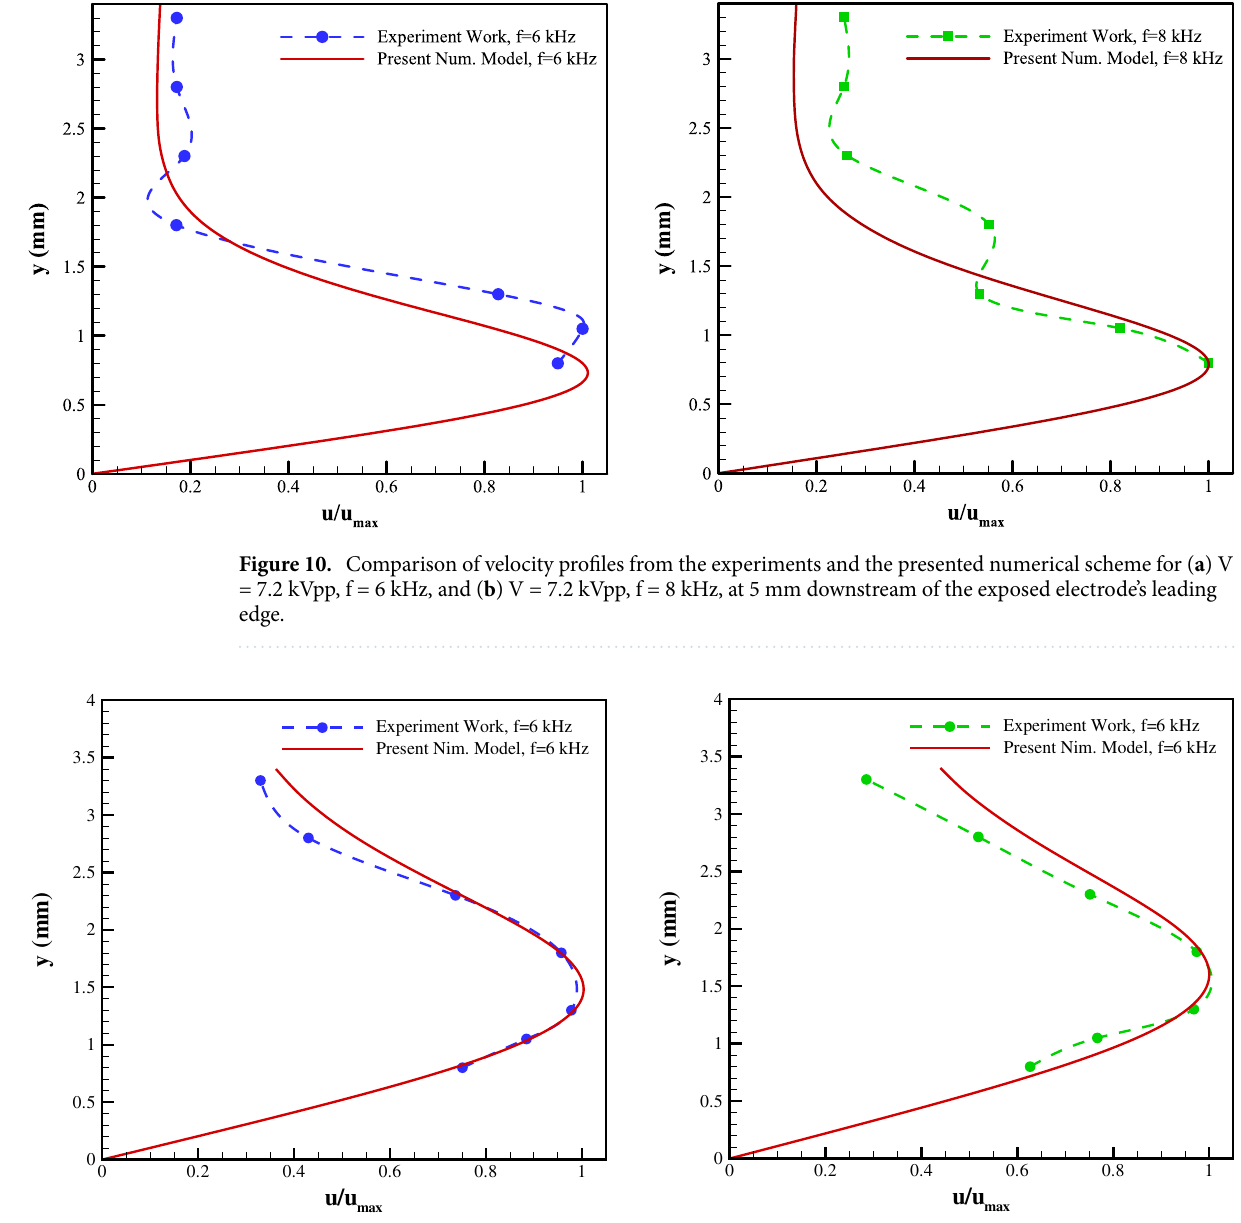
Figure 11. Comparison of velocity profiles from the experiments and the presented numerical scheme for ( a ) V = 7.2 kVpp, f = 6 kHz, and ( b ) V = 7.2 kVpp, f = 8 kHz, at 12.5 mm downstream of the exposed electrode’s leading